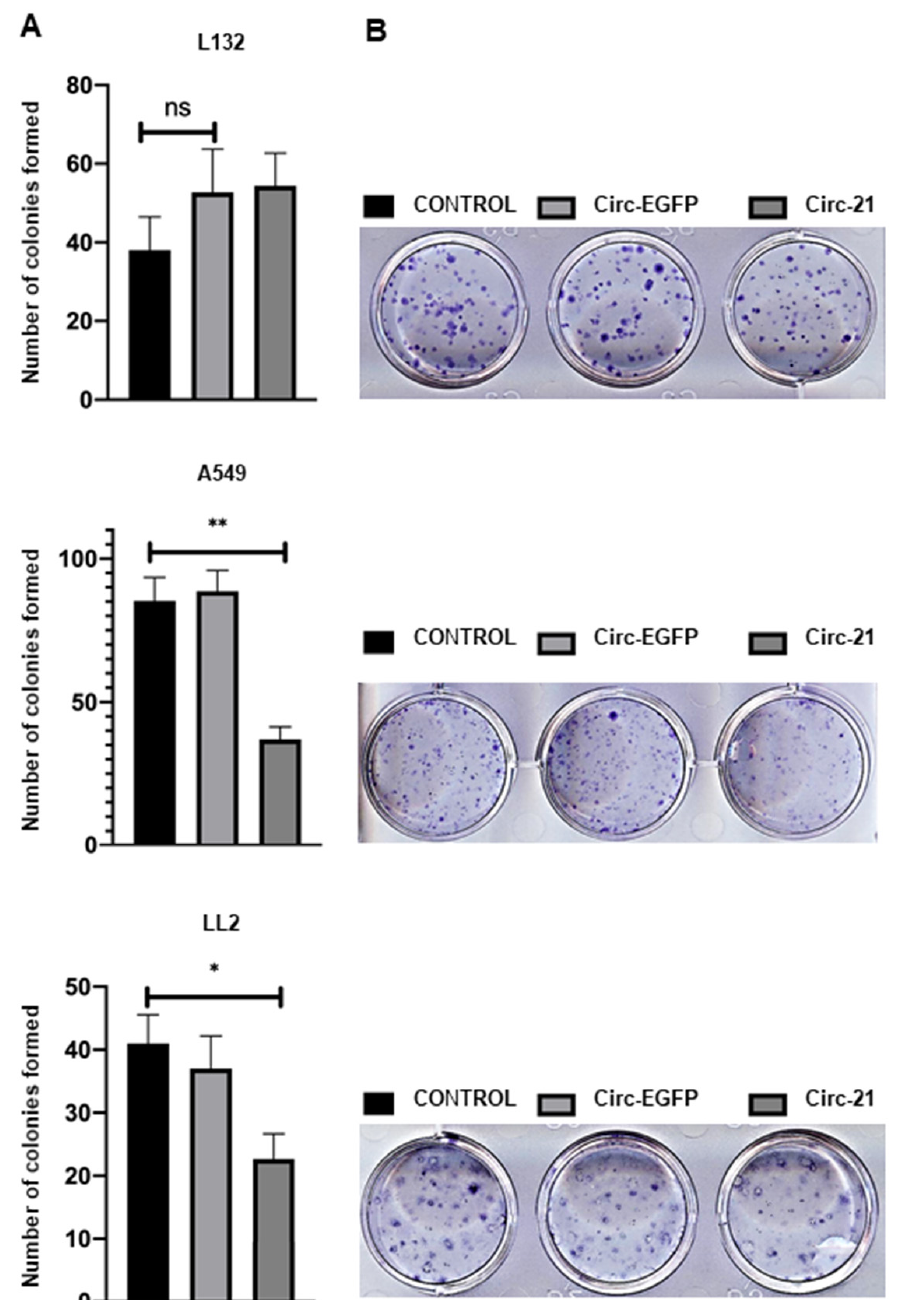
Figure 6. Effects of the miR-21 sponge on colony formation. ( A ) Colony formation assay. Values represent means ± SD of triplicate cultures. Statistical analysis was performed using a two-tailed t -test comparing the different samples against the control. * p < 0.05 and ** p < 0.01. Only statistically significant differences are shown and indicated with asterisks. ns = not statistically significant. ( B ) Representative image of wound-healing assay colony